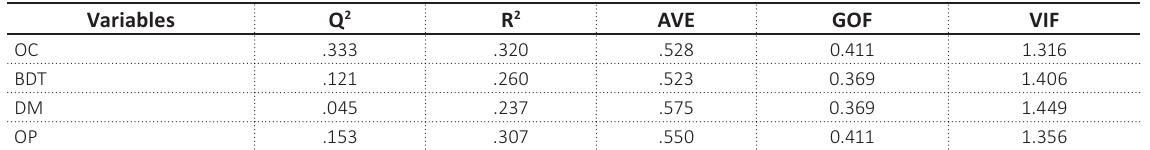
Table 4. Structural model assessment of eminence